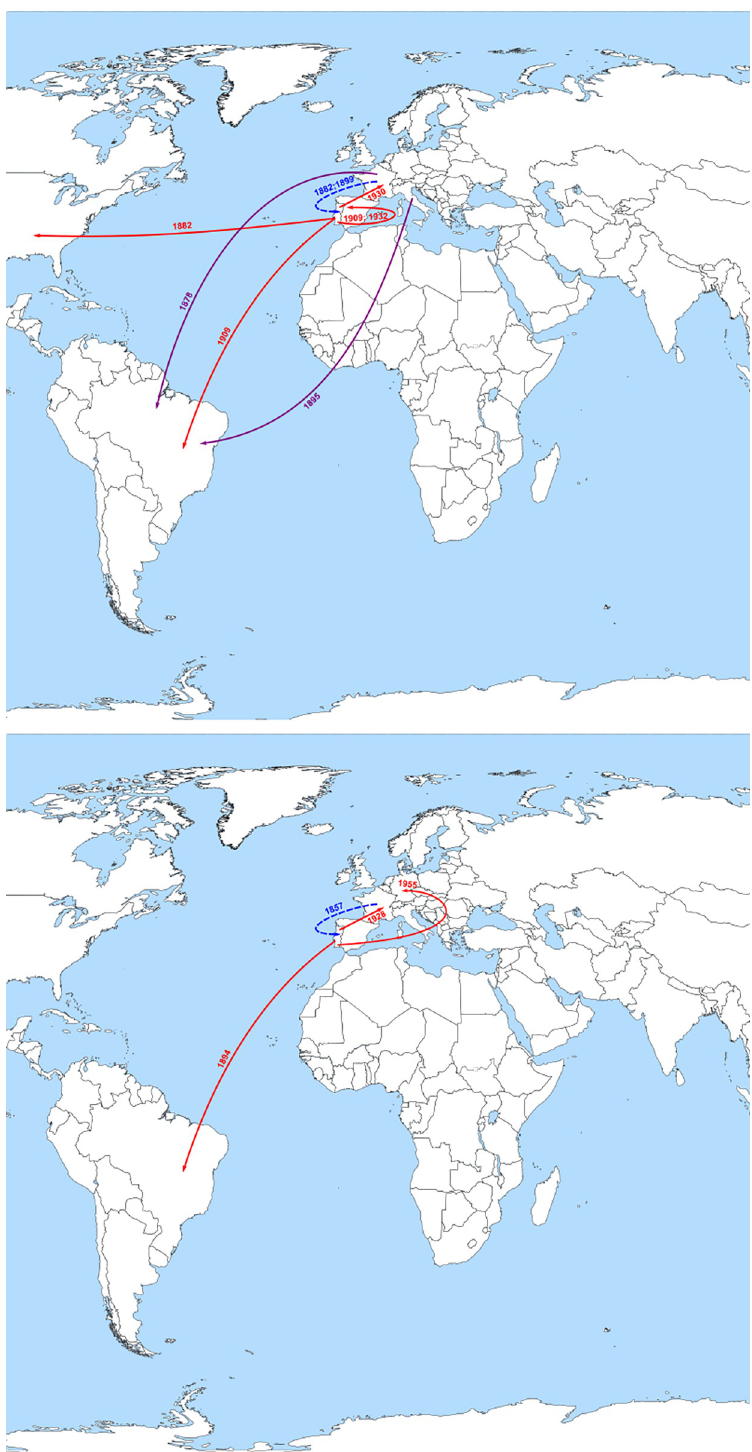
Fig 4. Probable major dispersal pathways of subgenotype HBV/D3 (above) and HBV/D4 (below) as estimated by phylogeographic analysis. The dashed blue arrows represent probable routes of introduction of the subgenotypes in Portugal. The solid red arrows represent the probable dispersion paths of subgenotype from Portugal towards other countries. Purple arrows show the contribution of other countries, besides Portugal, to the introduction of D3 subgenotype in Brazil. This figure is a derivative of “World map blank with blue sea.svg” licensed under the